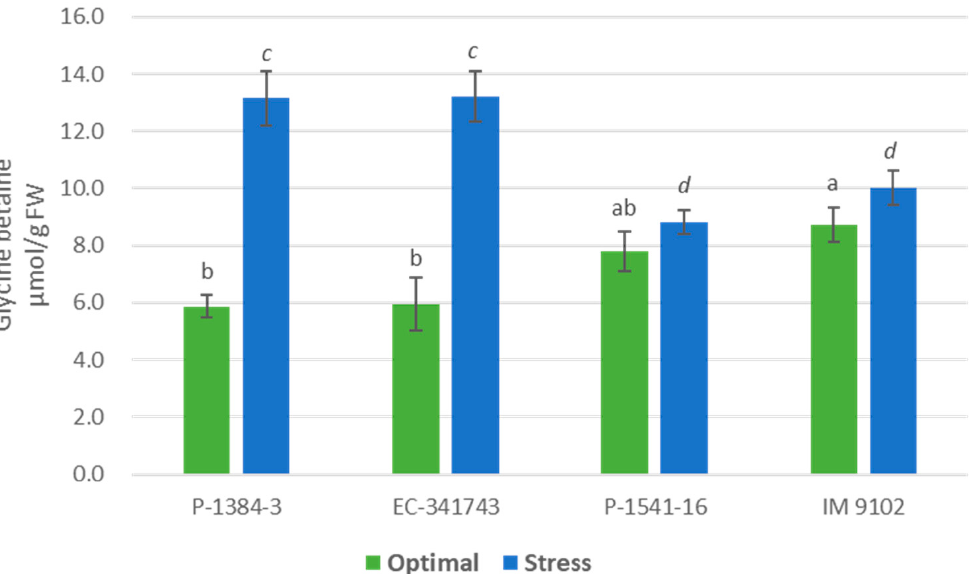
Figure 12. Glycine betaine content of four field pea genotypes under optimal and heat stress. Columns with different letters indicate significant difference at p ≤ 0.05 (Fisher LSD test).